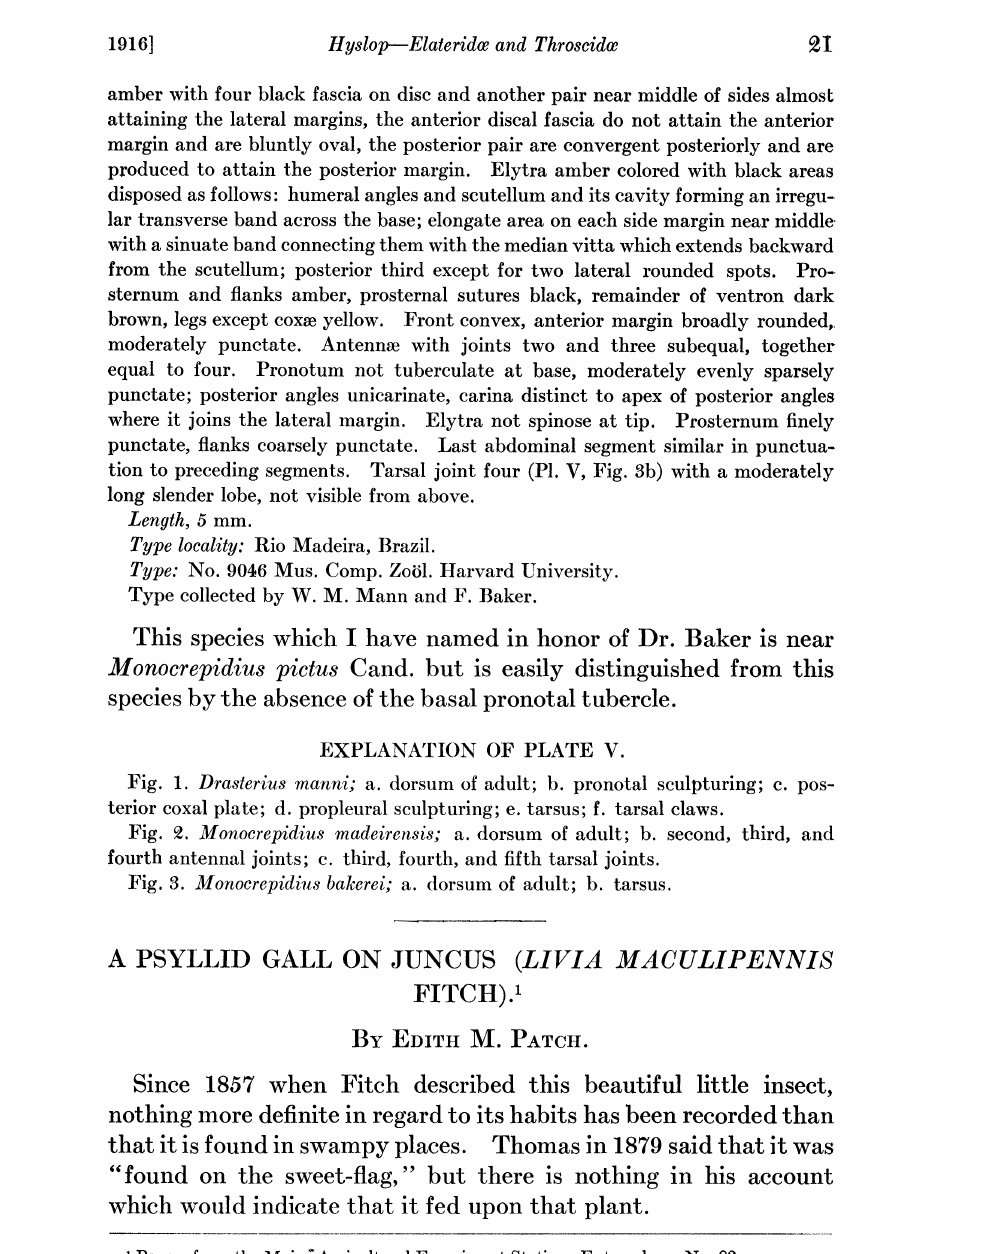
. Fig. 1. Drasterius manni; a. dorsum of adult; b. pronotal sculpturing; c. pos- terior coxal plate; d. propleural sculpturing; e. tarsus; f. tarsal claws. Fig. Monocrepidius madeirensis; a. dorsum of adult; b. second, third, and fourth antennal joints; c. third, fourth, and fifth tarsal joints. Fig. 3. Monocrepidius bakerei; a. dorsum of adult; b. tarsus. A PSYLLID GALL ON JUNCUS (LIVIA MACULIPENNIS